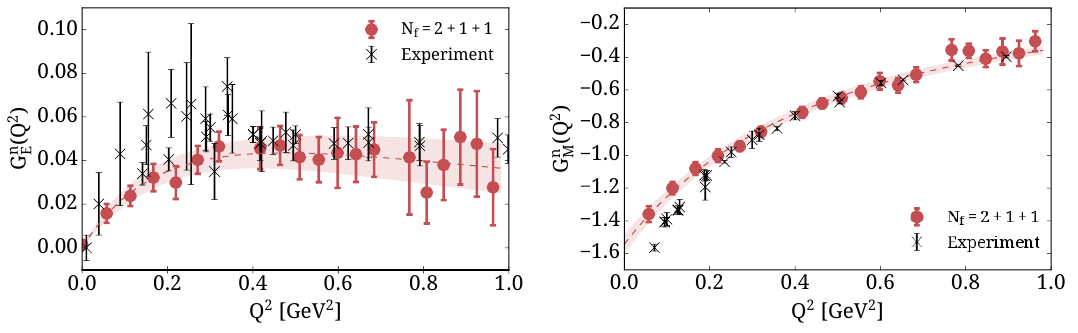
Figure 10: A comparison of recent lattice QCD and phenomenological results on the nucleon σ π -term fraction (left), on the strange σ N charm σ -term (lower right). The error band is the one associate with the analysis of c the twisted mass ensemble cB211.072.64. Grey circles are phenomenological studies using as input lattice data.